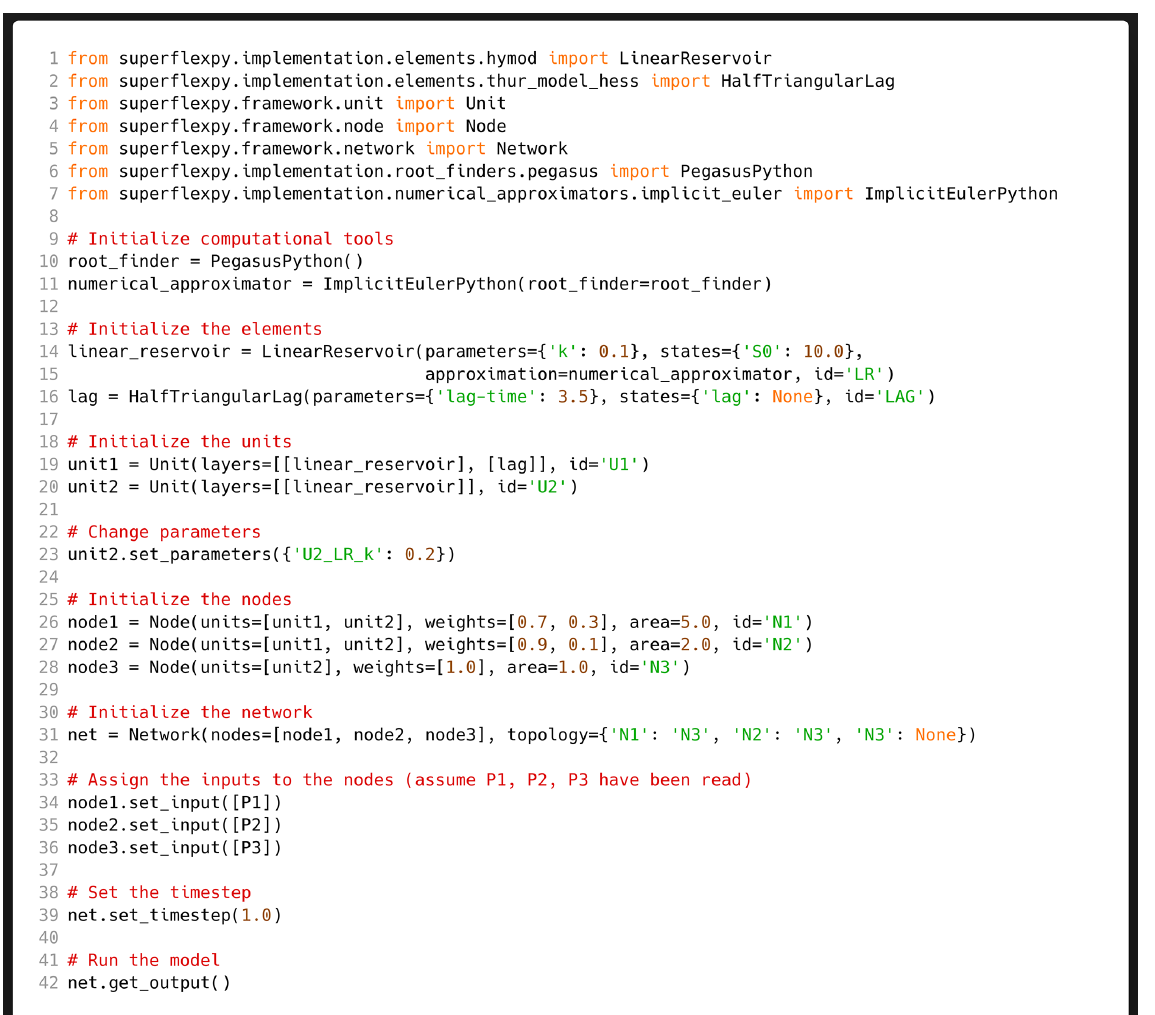
Figure 2. SuperflexPy code implementing the simple illustrative model in Fig. 1d.